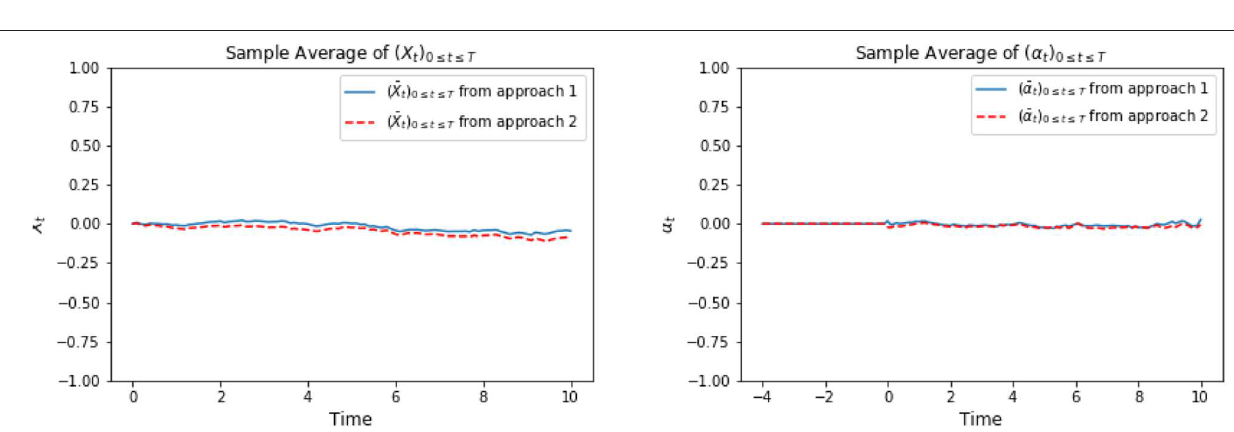
) t . The plot on the right show the comparison of sample mean of trajectories i 0 ≤ t i ≤ t N